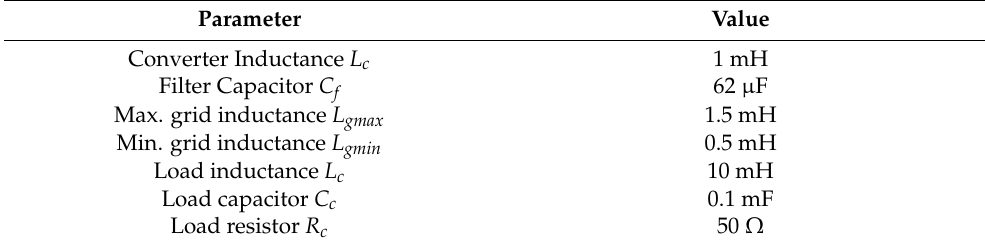
Figure 2. Single-phase standard nonlinear load (Rectifier load). Note that there is no restriction on the value of R c .